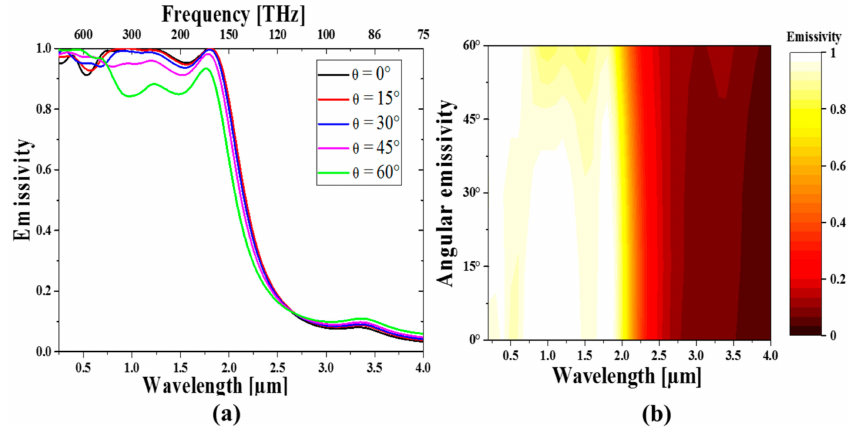
Figure 5. The emissivity of the proposed metamaterial at different angular emissivity, with dimensions of h 1 = 15 nm, h 2 = 40 nm, h 3 = 120 nm, r 1 = 120 nm, r 2 = 60 nm, n = 11 and Λ = 400 nm: ( a ) as lines graph; ( b ) as 2-D color